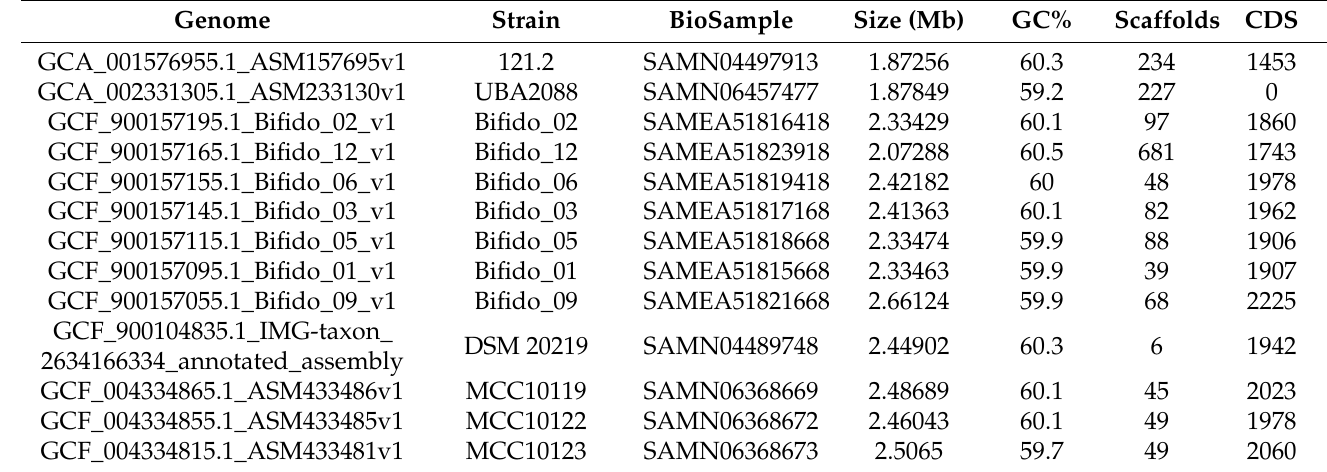
Table 2. Publicly available B. longum genomes used in this